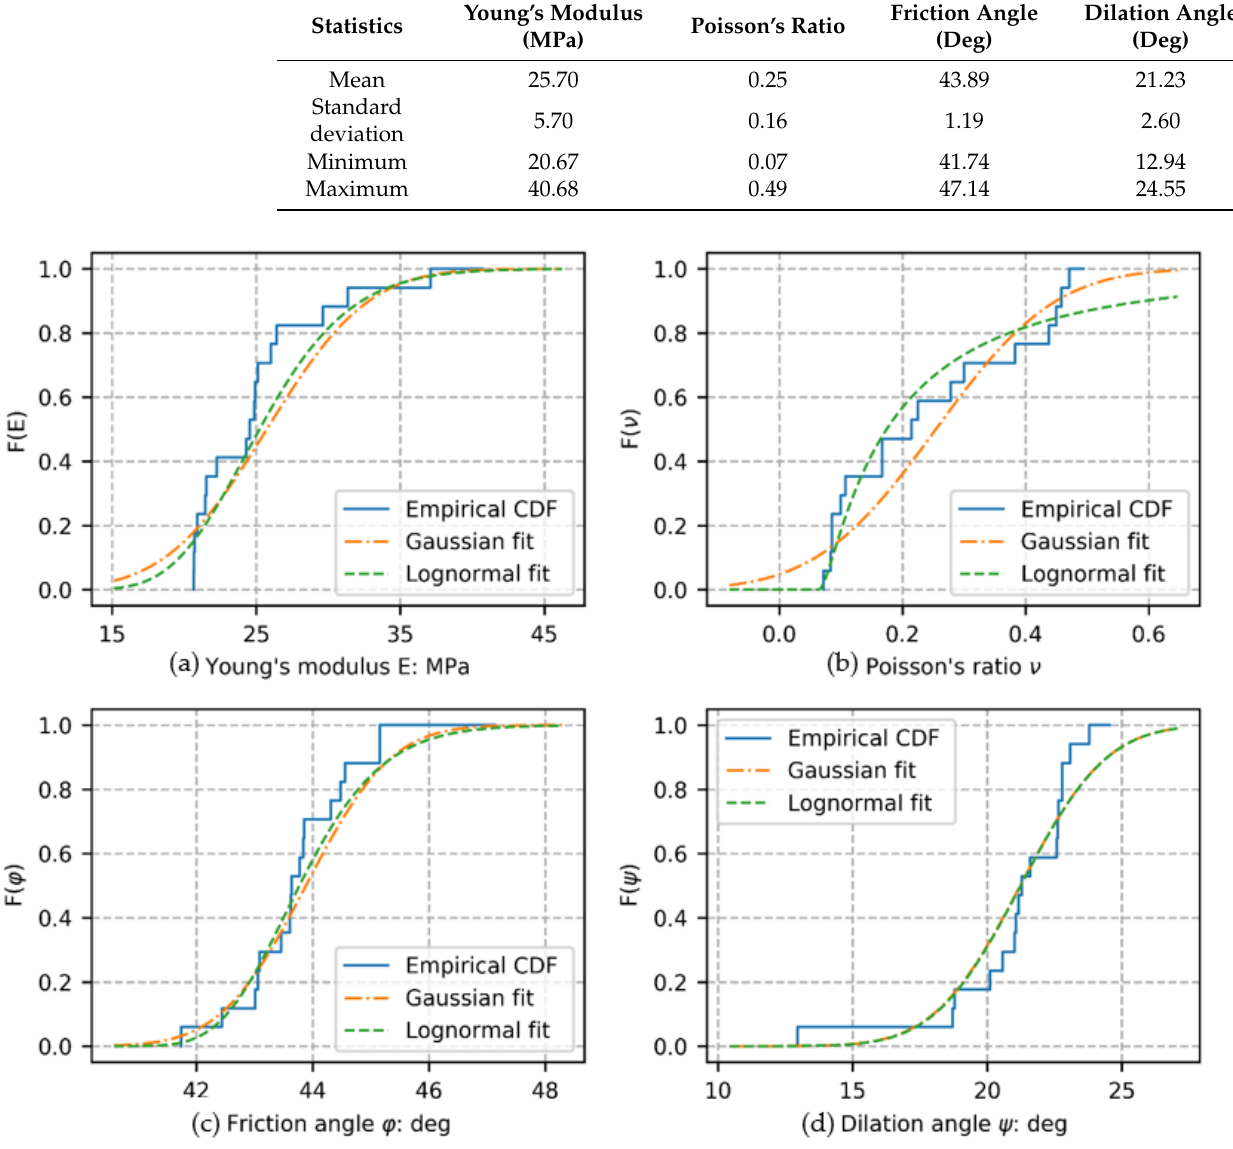
Figure 3. Empirical cumulative density function of each constitutive parameter, including Gaussian and lognormal model fits (as descriptive reference only): Young’s modulus ( a ), Poisson’s ratio ( b ), Friction angle ( c ), and dilation angle ( d ). ( b ), Friction angle ( c ), and dilation angle ( d